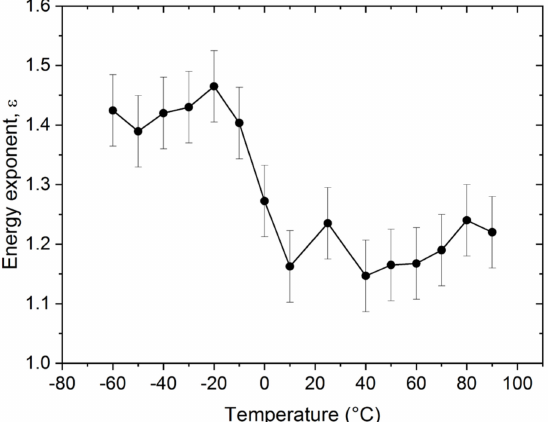
Figure 5. Temperature dependence of power exponent ( ε ) of the energy distributions.